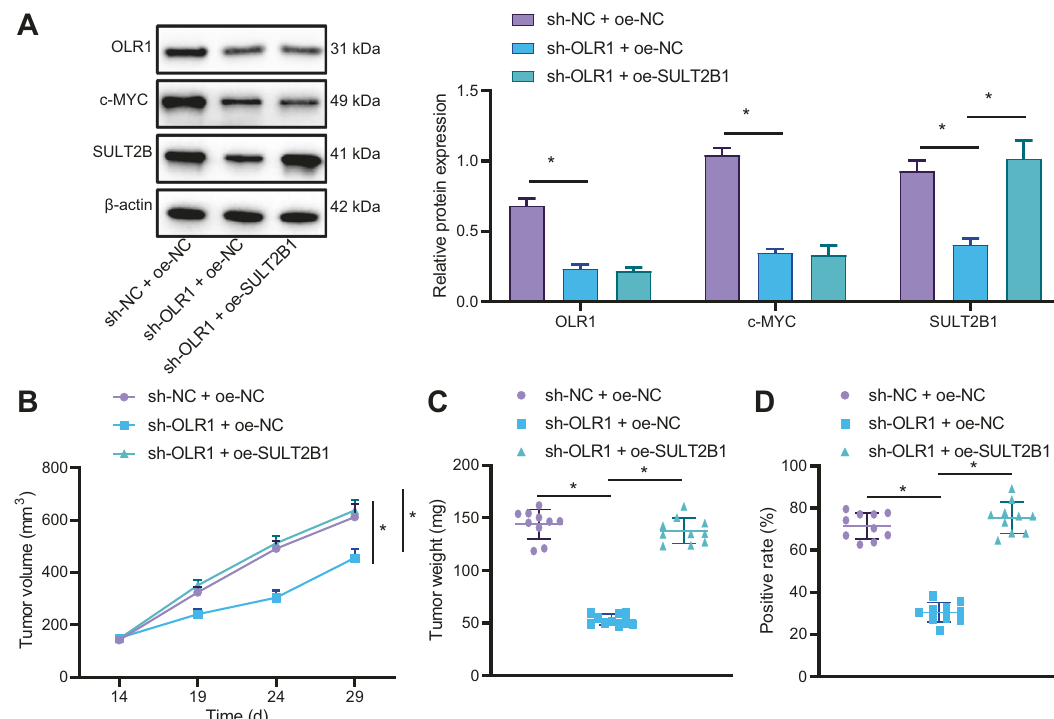
Fig. 7 The inactivation of OLR1 /c-MYC/SULT2B1 axis restrains tumorigenicity and chemoresistance of colon cancer cells in nude mice. A The protein expression of LOX-1, c-MYC, and SULT2B1 detected by western blot analysis. B Growth curve of subcutaneous colon cancer xenograft in nude mice. C Weight of tumor in nude mice. D The expression of Ki67 in tumor tissues of nude mice detected by immunohistochemistry ( n = 10 mice/group). * p < 0.05.